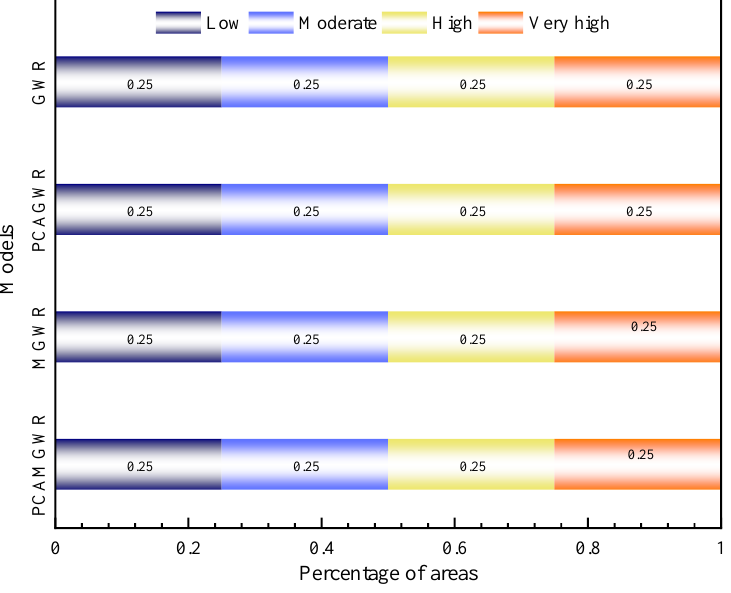
Figure 10. Area percentage of various landslide susceptibility levels produced in LSMs.